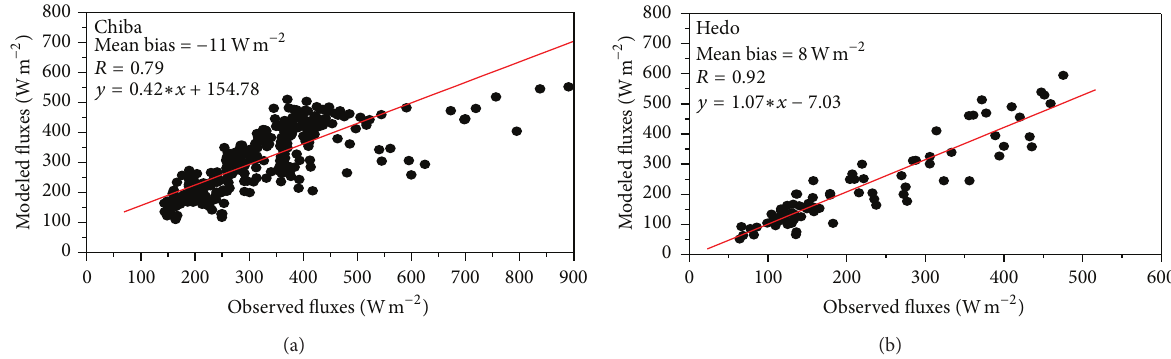
Figure 3: Comparison of observed and model simulated fluxes using initial guess of 𝜏 𝑐 and 𝑅 (diffuse fluxes).